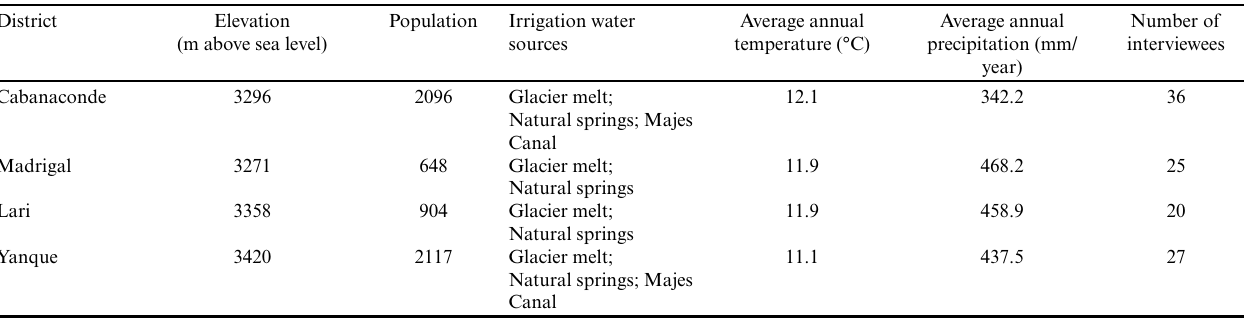
Table 1 . Characteristics of study districts and number of interviewees.